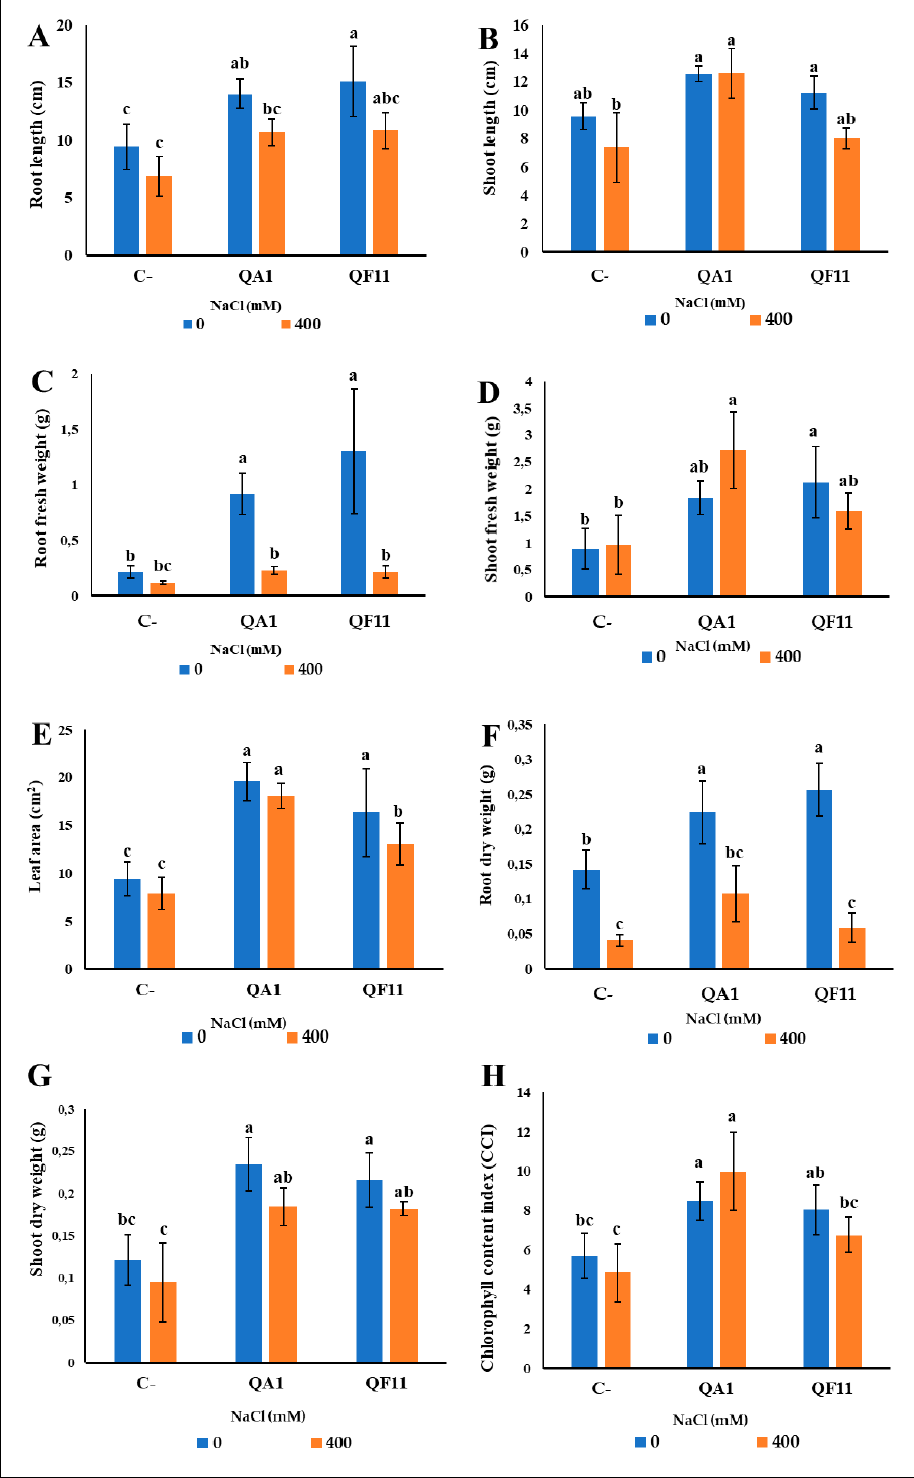
Figure 7. E ff ect of selected PSB on quinoa plant growth after 45 days of cultivation under non-saline (0 mM NaCl) and saline (400 mM NaCl) irrigations. ( A ) Root length, ( B ) shoot length, ( C ) root fresh weight, ( D ) shoot fresh weight, ( E ) leaf area, ( F ) root dry weight, ( G ) shoot dry weight, ( H ) leaf chlorophyll content index. The values represent means of replicates ( n = 4) ± standard deviations. The di ff erent letters in superscript (a, b, c ... ) indicate the statistically significant di ff erence at 95% between